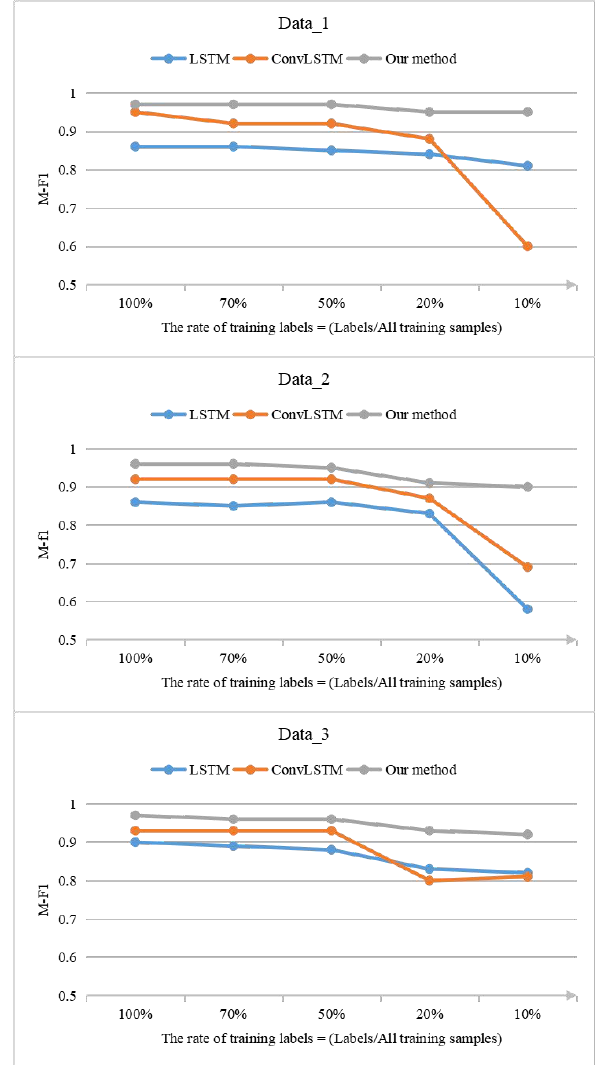
Figure 10. The results of weighted F1 score of comparative experiments in the various proportion of labelled training samples in three study